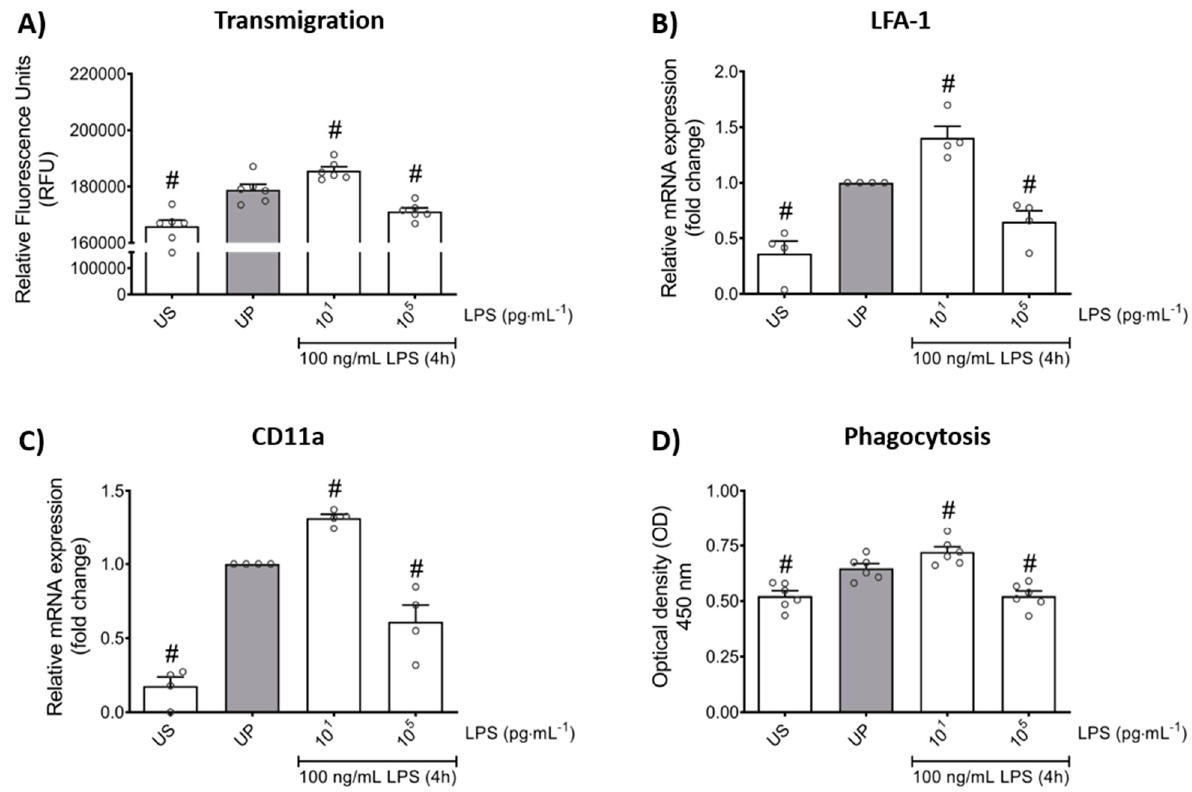
Figure 5. Effects of low- and high-dose LPS priming on the migratory effects and phagocytic activity of mouse bone marrow neutrophils in vitro. Cells were primed with different doses of LPS (low-dose: 10 pg/mL; high-dose: 100 ng/mL) and re-challenged on day 2 with a fixed dose LPS (100 ng/mL), as described. ( A ) Transmigration of neutrophils (n = 6) was analyzed by the CytoSelect 96-well Cell Migration Assay, as described (check Materials and methods, Section 4.8) and data were expressed as relative fluorescence units. RNA samples were collected 4 h after the second stimulation by LPS (100 ng/mL) and analyzed for ( B ) LFA-1 (n = 4) and ( C ) CD11a (n = 4) by real-time PCR normalized to GAPDH representing relative values to unprimed state (assigned as 1.0). ( D ) Phagocytic activity of mouse bone marrow neutrophils (n = 6) was assessed using a CytoSelect 96-Well Phagocytosis Assay kit (E. coli Substrate) and data were expressed as optical density (further check Material and methods, Section 4.9). Data are shown as scatter dot plots, mean + SEM, # p < 0.05, # significant differences vs. unprimed condition (UP, gray column).